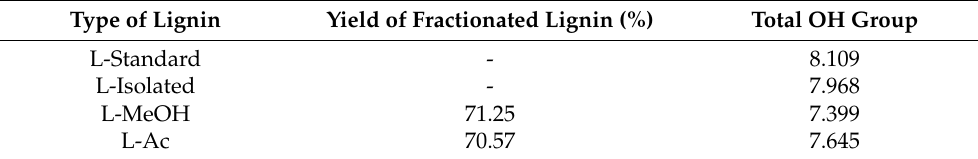
Table 2. The yield and total phenolic hydroxyl group of isolated and fractionated lignin. Type of